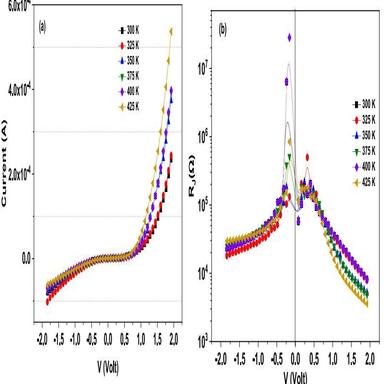
(a) Plot of I–V characteristics, and (b) Plot of RJ vs. V at different temperatures of PVA/p-Si heterojunction.